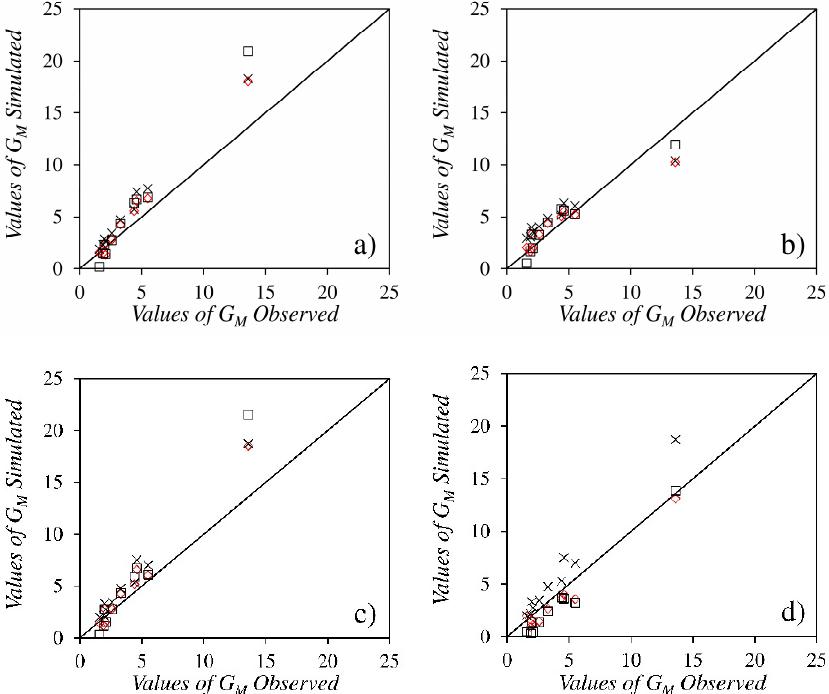
Figure 8. Values of simulated vs. observed G M . Applying the models with mean values of C w and the particular discharge coe ffi cients C dVS and C dWR for each test ( a ), with mean values of C w , C dVS and C dWR ( b ); with mean values of C w and the fits C dVS ( u o ) and C dWR ( u o ) ( c ); with fits C w,M1 ( δ ), C w,M2 ( δ ), C dVS ( u o ) and C dWR ( u o ) ( d ). ◊ , model M1; □ , model M2; ×, model M3.